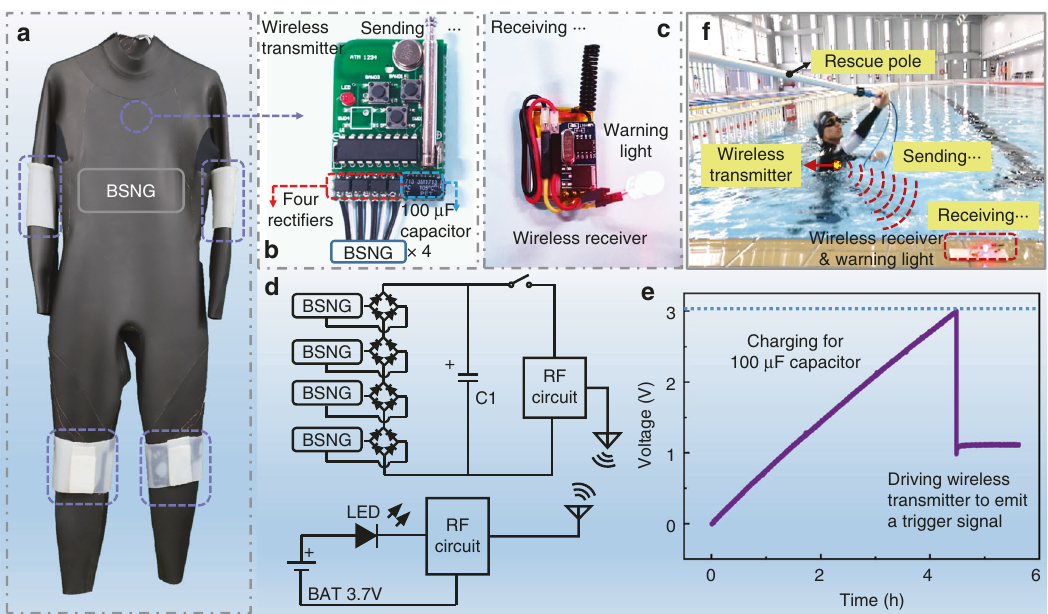
Fig. 5 Undersea rescue system based on bionic stretchable nanogenerator. Photograph of undersea rescue system which included ( a ) integrated energy harvesting diving suit, ( b ) integrated wireless transmitter and ( c ) wireless receiver integrated with a red warning light. d Simple circuit diagram of